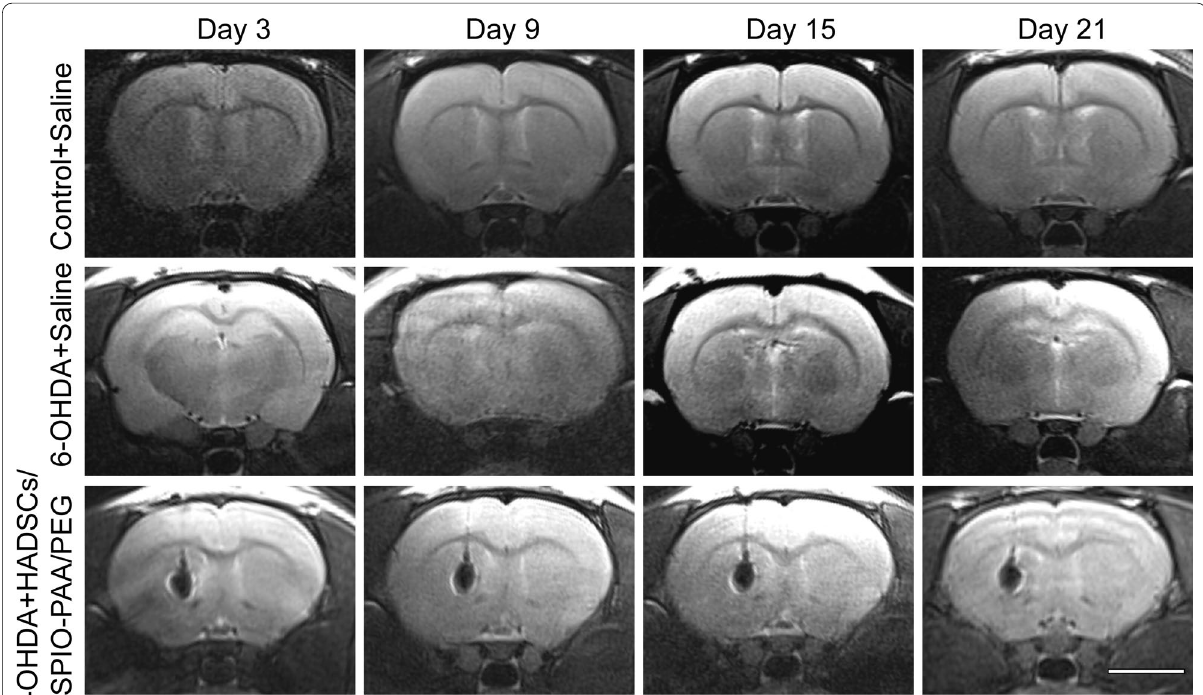
Fig. 5 Representative MRI images of the brains at 3 days, 9 days, 15 days and 21 days followed by transplantation with USPIO-PAA/PEG labeling HADSCs or saline. The MRI images of the corresponding controls, i.e. normal rats or PD rat model injected with saline, were shown in the 1st and 2nd rows, respectively. Note that compared to the negative signals in the control, the rat brains transplanted with USPIO-PAA/PEG-labeled HADSCs showed a constant and clear MRI signals up to 21 days. The bar represents 5